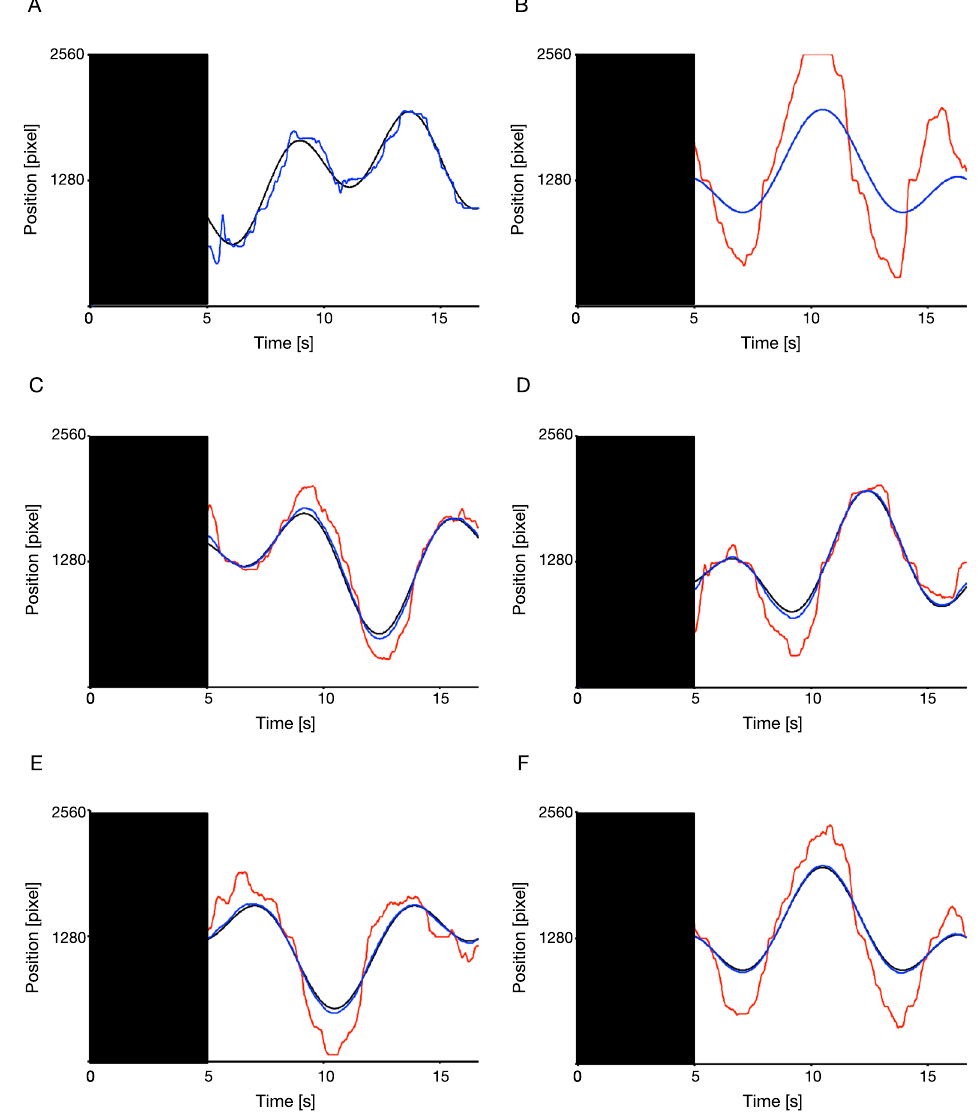
Zero (2560) along the vertical axis indicates the left (right) side of the display. The black areas represent the preparatory epoch where the cursor was invisible. The black curved lines show the center of the target trajectories and colored lines show the typical cursor movements of a participant (blue lines: the apparent cursor movements, red lines: the actual cursor movements). It is noted that participants could not see the actual cursor movement in this